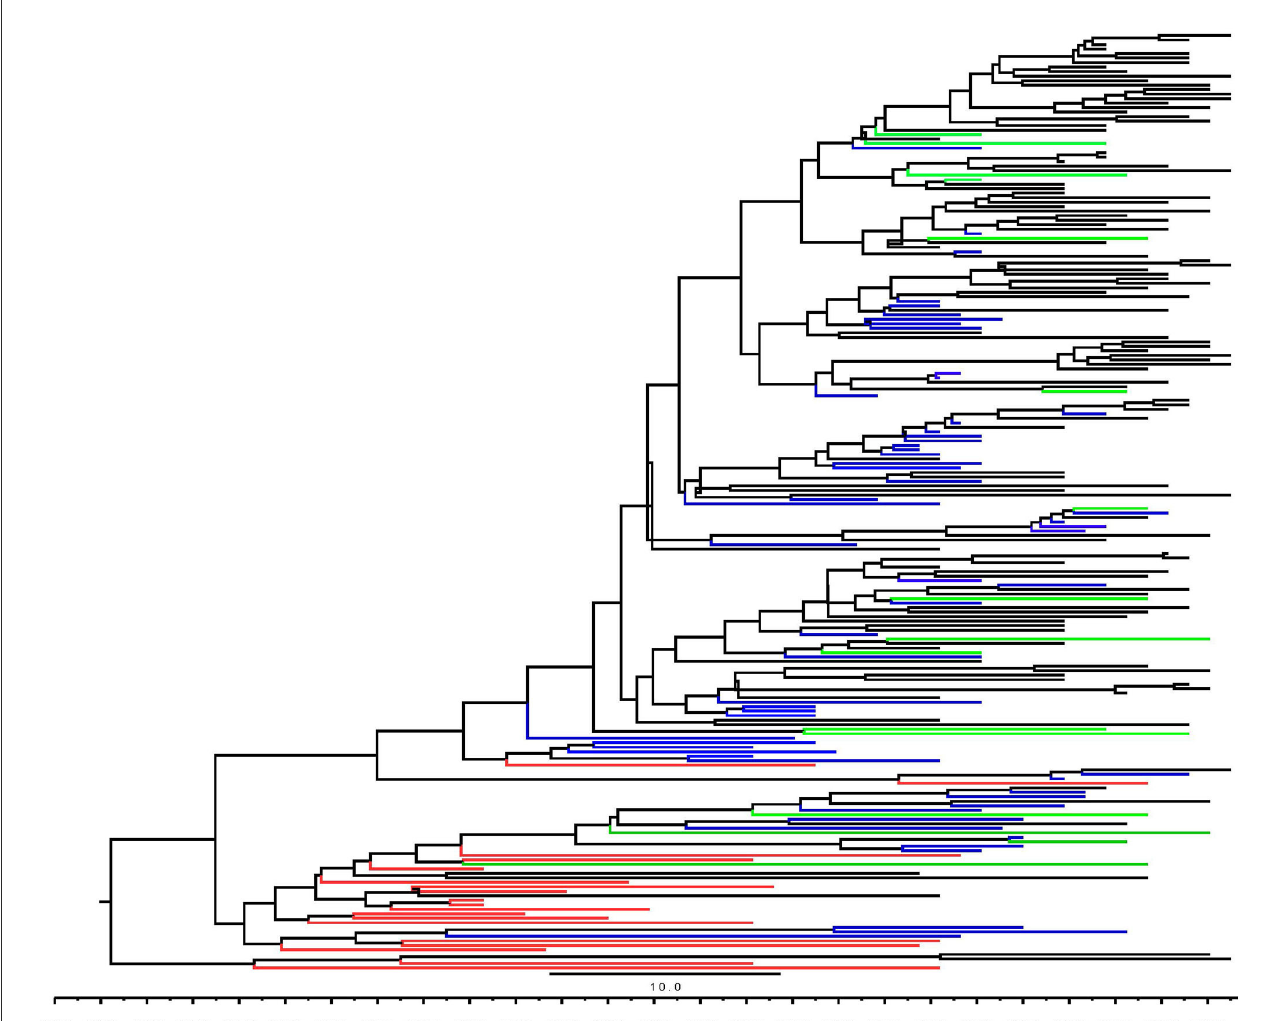
FIGURE2 Maximum clade credibility trees based on partial pol gene segment of HIV-1. Black line indicates the sequence of HIV-1 from Fuyang city, green line indicates the sequences from other cities in Anhui province, blue line indicates the sequences isolated from other provinces of China except Anhui, red line indicates sequences from other